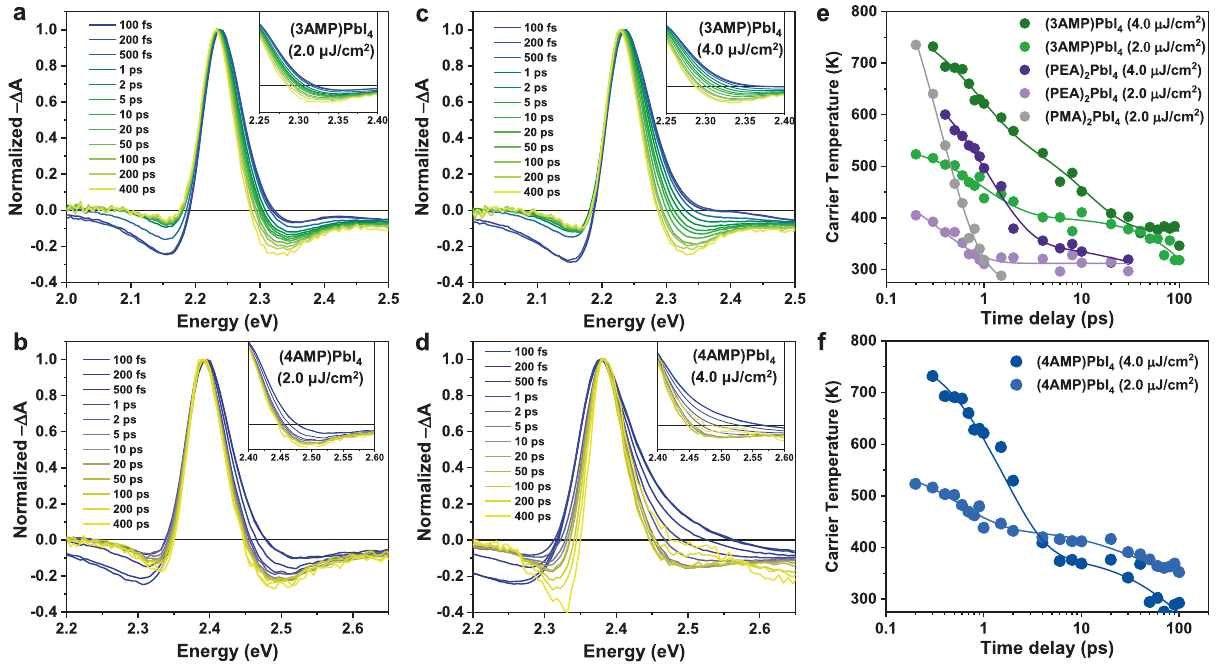
Fig. 2 Hot carrier cooling dynamics of 2D Dion – Jacobson perovskites. Normalized transient absorption spectra measured at an excitation wavelength of ( a , c ) 330 nm for the (3AMP)PbI 4 fi lm and ( b, d ) 316 nm for the (4AMP)PbI 4 fi lm with a pump fl uence of 2.0 μ J/cm 2 and 4.0 μ J/cm 2 . Extracted hot-carrier temperatures as a function of delay time for ( e ) (3AMP)PbI 4 and ( f ) (4AMP)PbI 4 at different pump fl uences (2.0 μ J/cm 2 and 4.0 μ J/cm 2 ). The hot carrier temperatures of (PMA) 2 PbI 4 and (PEA) 2 PbI 4 are shown with gray and purple circles for comparison. The solid lines represent fi ts to a biexponential decay